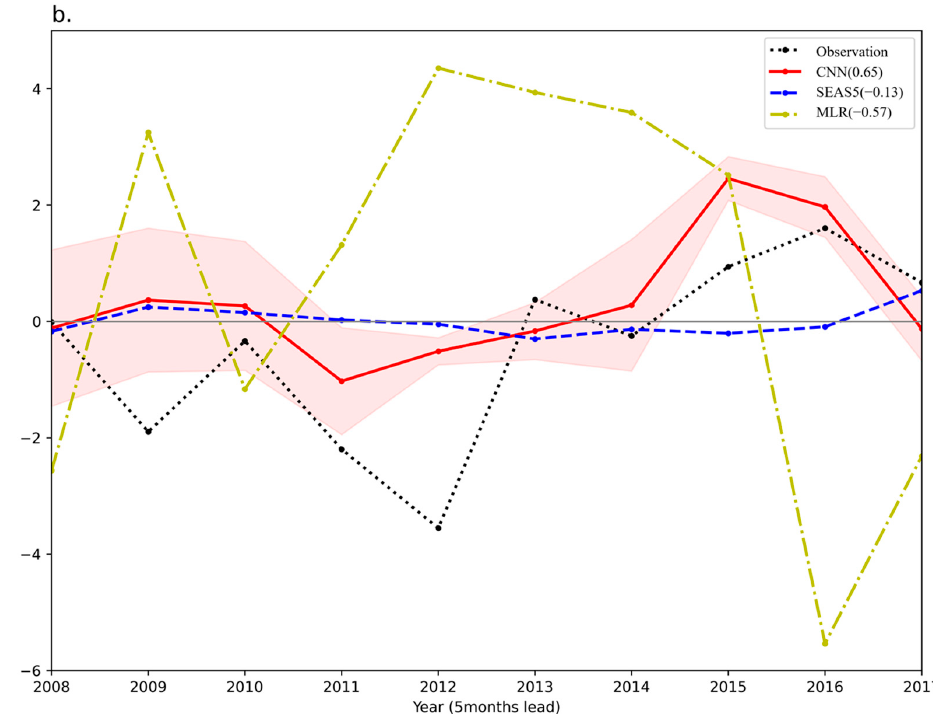
Figure 4. ( a ) Same as Figure 3, but for 2008–2017. ( b ) Time series of observed NCDT (black dotted line) and its 5-month-lead prediction of CNN (red solid line; ensemble distributions are shaded by red), SEAS5 (blue solid line), and MLR (yellow dash-dotted line). Correlation skills are indicated in parentheses.